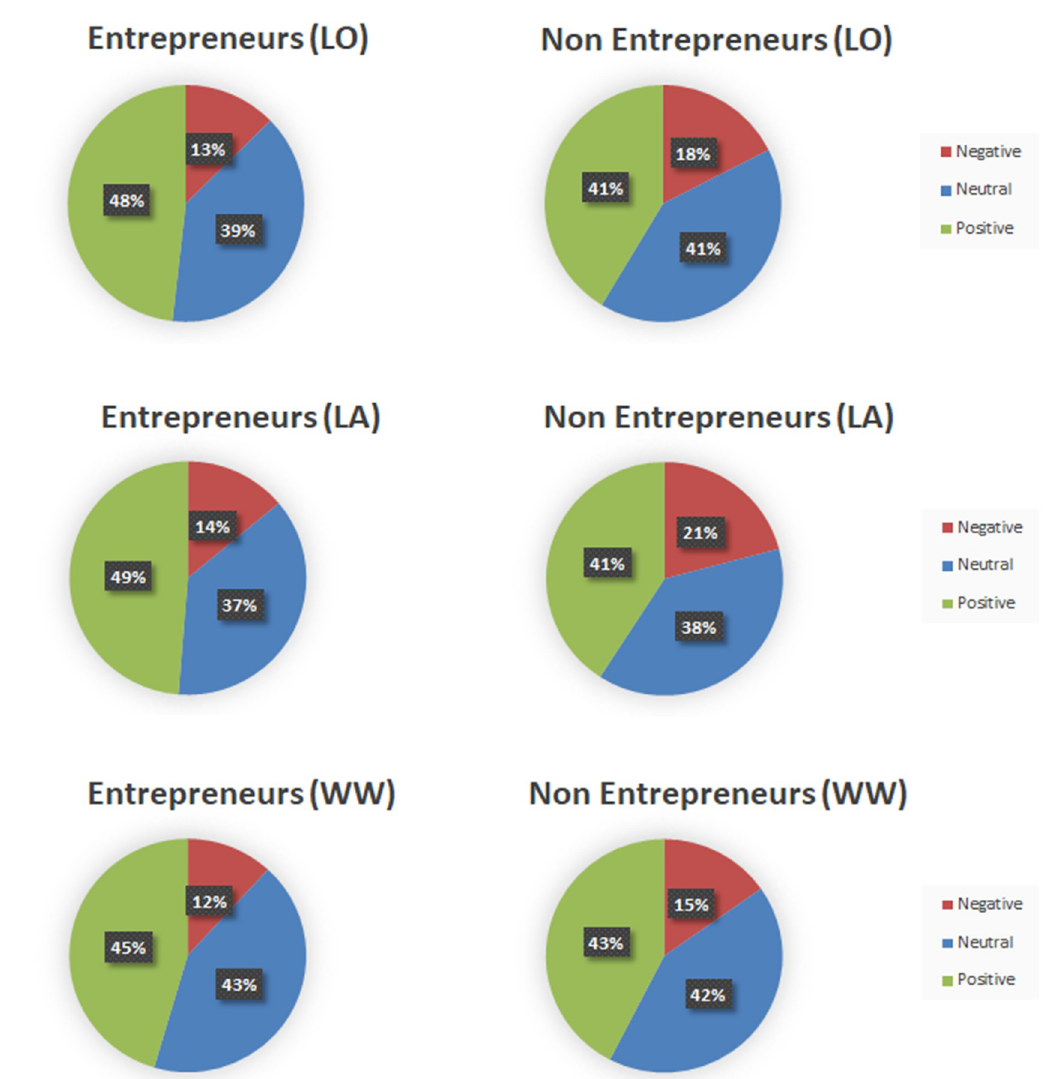
Fig 1. Tweet emotional comparison between entrepreneurs and non-entrepreneurs for London (top), Los Angeles (middle) and worldwide (tweet